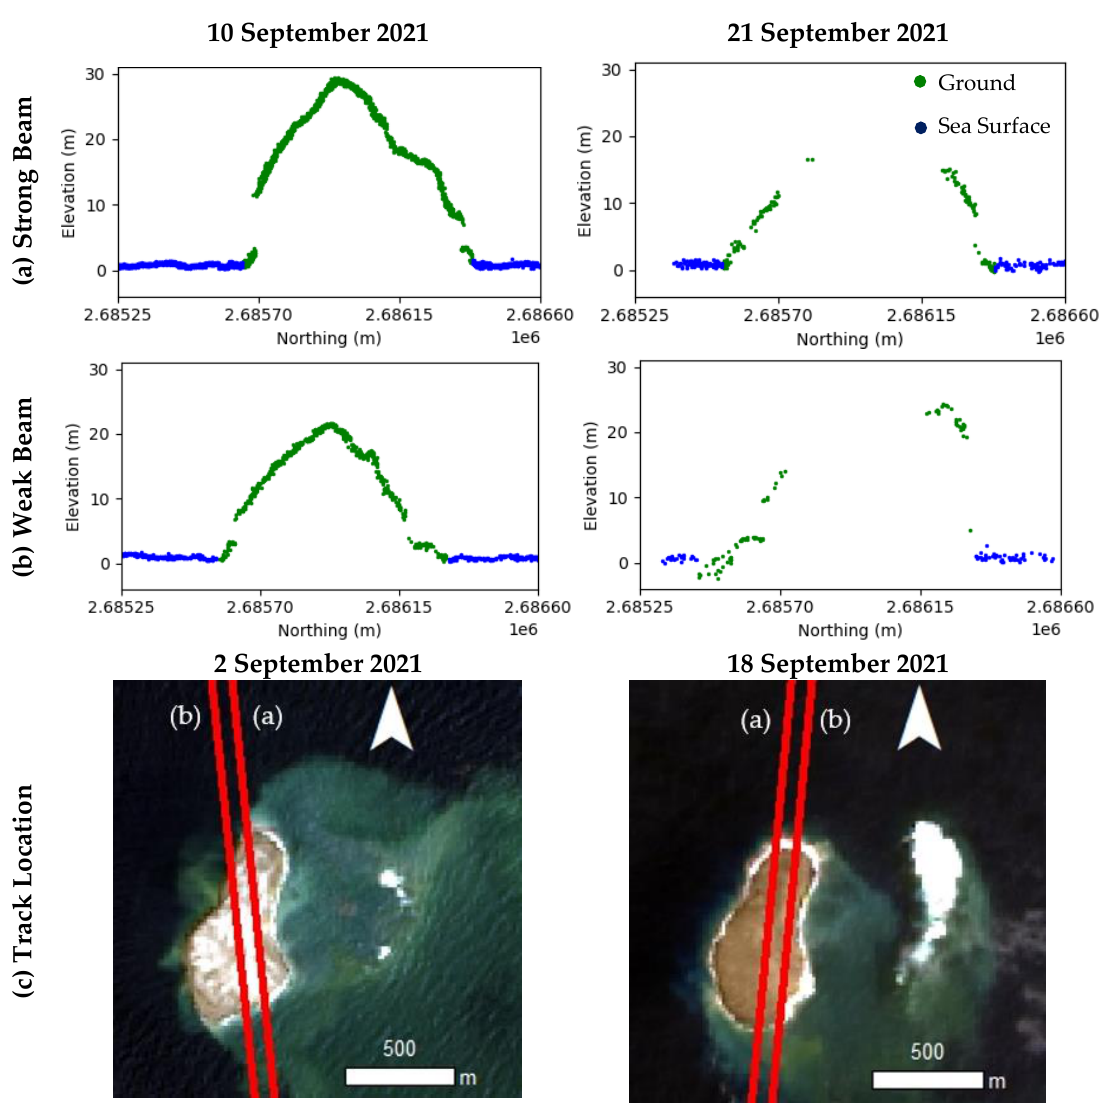
Figure 4. ICESat-2 ( a ) strong and ( b ) weak ICESat-2 altimetry tracks manually classified as (green) ground and (blue) sea surface. ( c ) ICESat-2 track locations overlain on Landsat-8 pan-sharpened imagery to provide context for the altimetry data (Landsat-8 images courtesy of the U.S. Geological Survey).